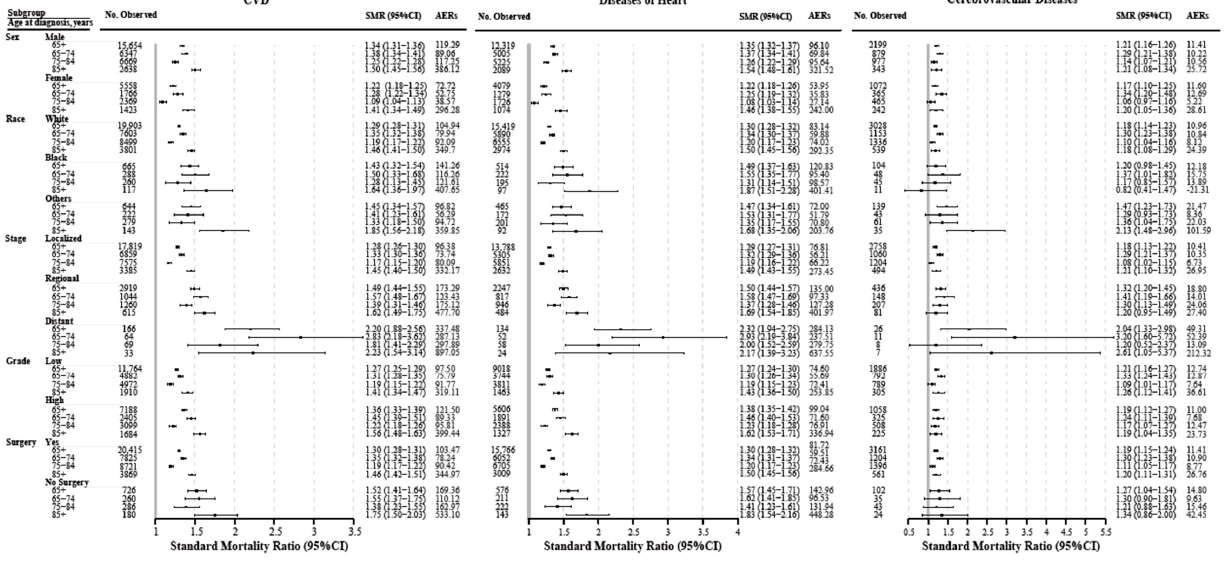
Figure 4. The risk of cardiovascular death among older patients ( ≥ 65 years) with bladder cancer according to age at diagnosis. Abbreviations: CVD, cardiovascular disease.